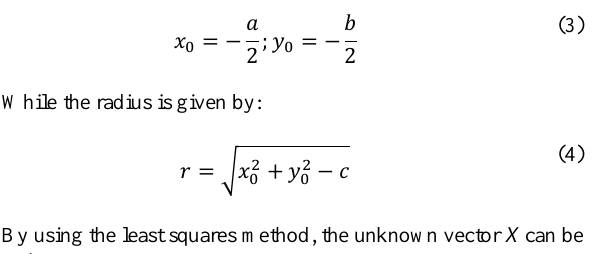
Figure 7. The scheme of the geodetic network around the chimney.